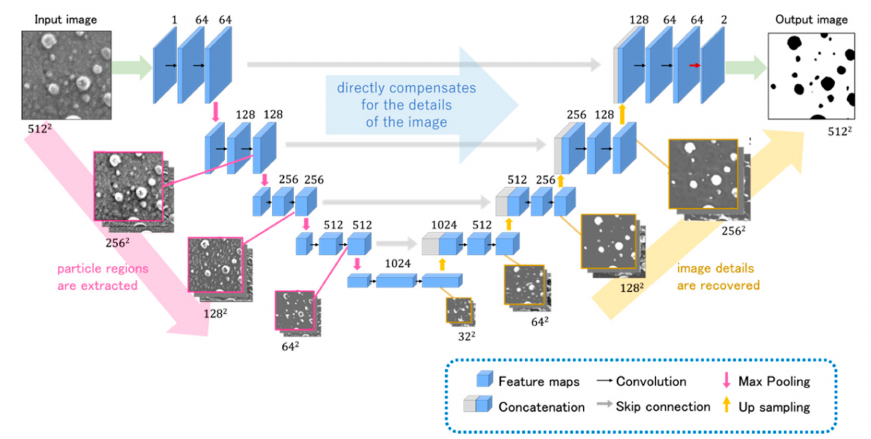
Figure 8. U-Net architecture. The channel number of feature maps is indicated on top of the boxes and the feature map size at the lower left/lower right edge of the image. In the experiment, it was enhanced by optional dropout layers following the CNN layers and by working with different feature map sizes, with the input being 1024 × 1024 pixels and convolutions used to preserve the shape. Source: [47].